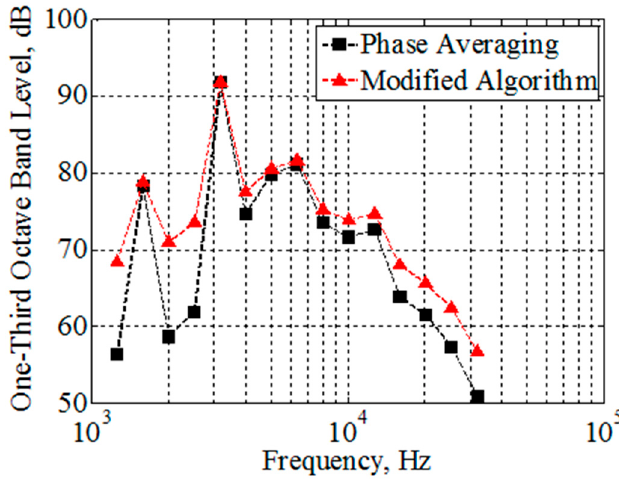
Figure 6. Comparison of one-third octave tone spectra of single-shaft fan data.